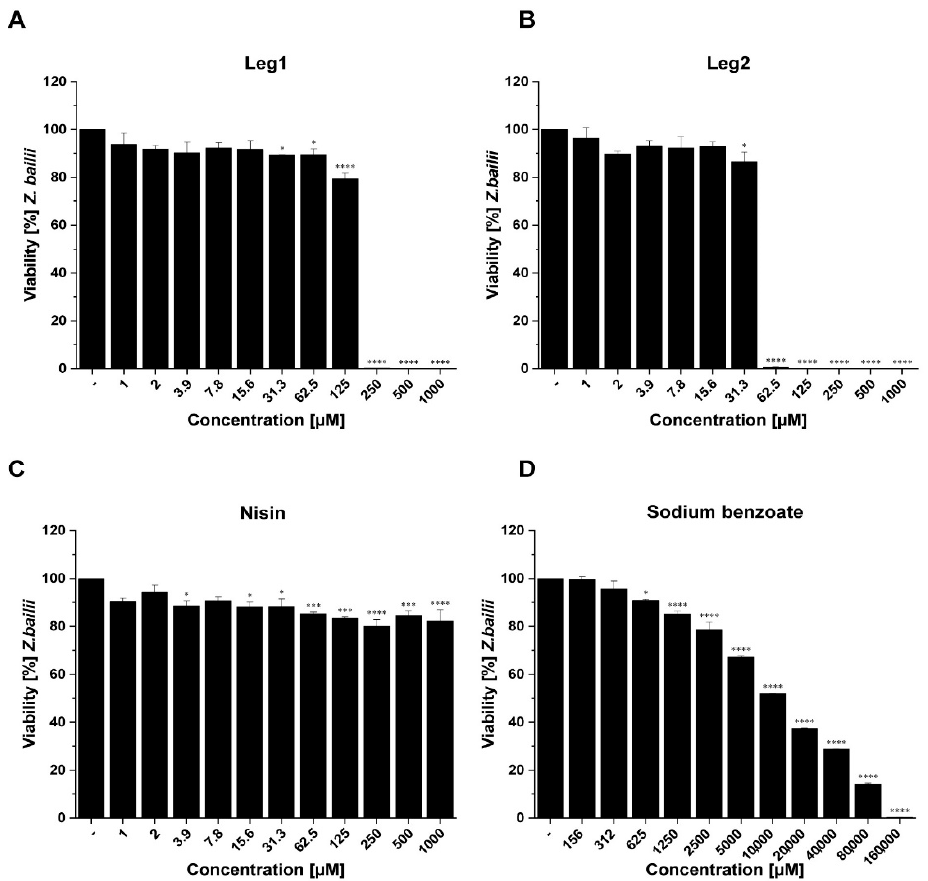
Figure 4. Results of flow cytometry measurements of antifungal activity using ( A ) Leg1, ( B ) Leg2, ( C ) nisin, and ( D ) sodium benzoate against Z. bailii . Water ( − ) was used as negative control. Viability (as mean ± SD of triplicates) is expressed as percentage in relation to the negative control. The levels of significance were * p < 0.05, ** p < 0.01, *** p < 0.001, **** p < 0.0001.